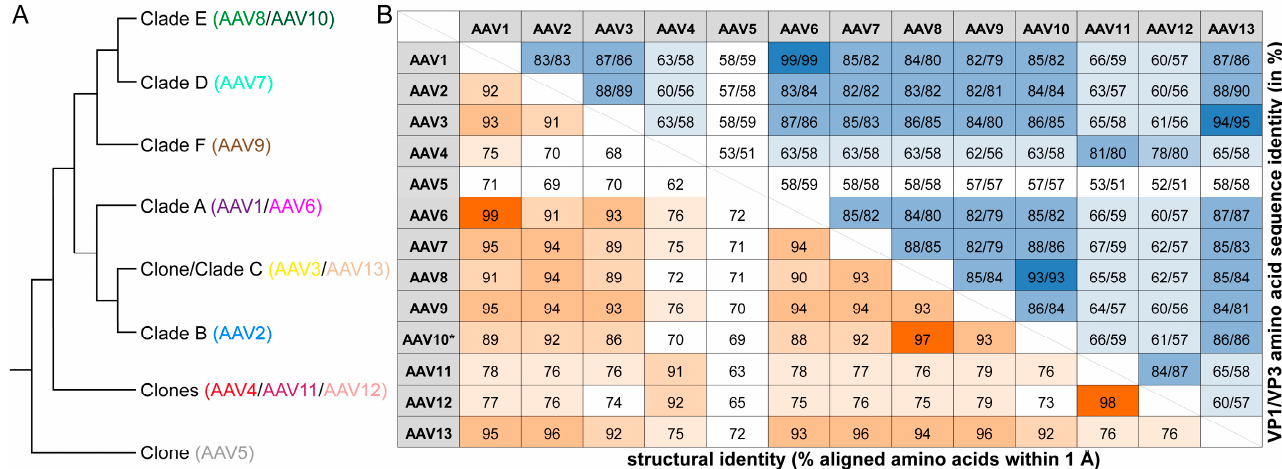
Figure 5. Relationship of the AAV serotypes. ( A ) Cladogram showing the assignment of the AAV serotypes to their clades as proposed by Gao et al. [3]. ( B ) Amino acid sequence identity of the AAV serotypes given as percentage for VP1 and VP3 or the structural identity as a percentage of aligned amino acids within 1Å when superposed. High values are colored in dark blue or orange and lower values in lighter shades of each color, respectively. * For AAV10, the VP structure of AAVrh.39 was utilized, which varies by a single aa from AAV10.